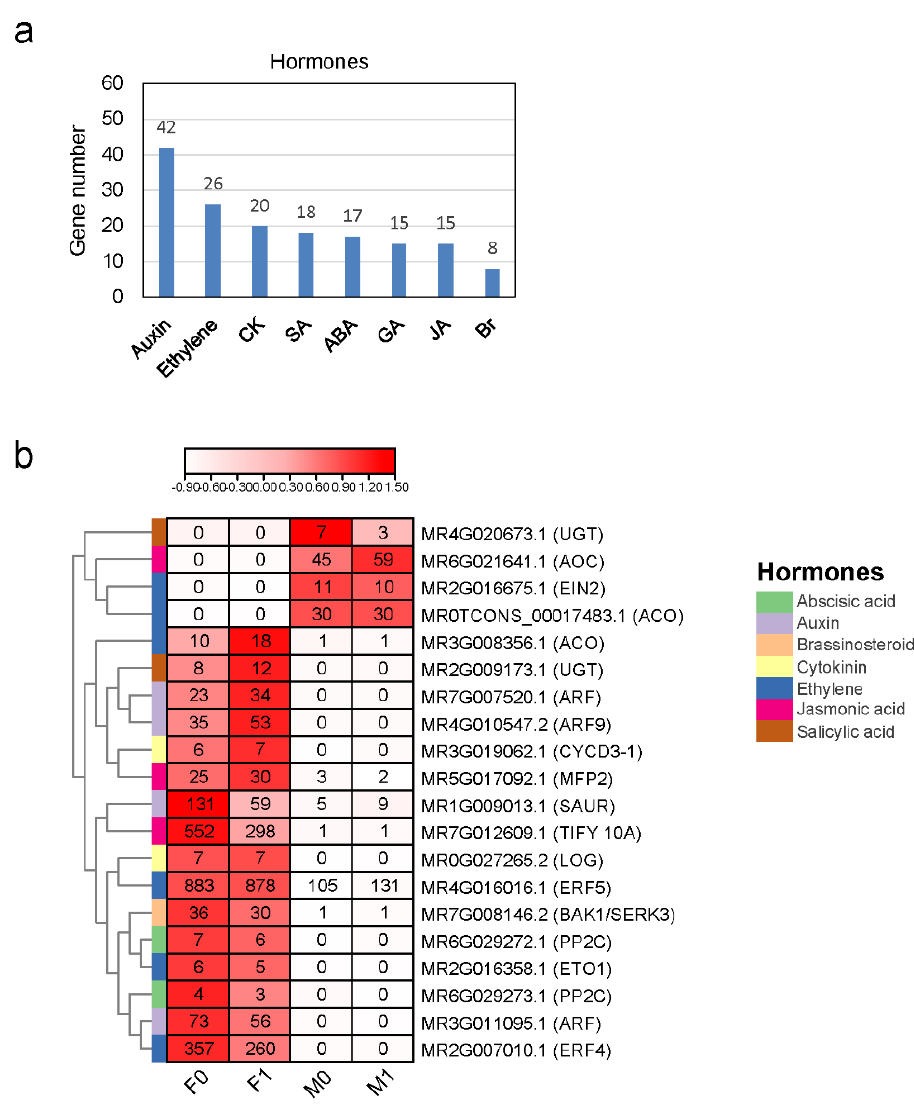
Figure 3. The distribution and expression of hormone-related genes. ( a ) The distribution of 184 hormone-related genes. ( b ) Heat map of sex-biased DEGs related to hormones, with the FPKM value of genes shown in the box.